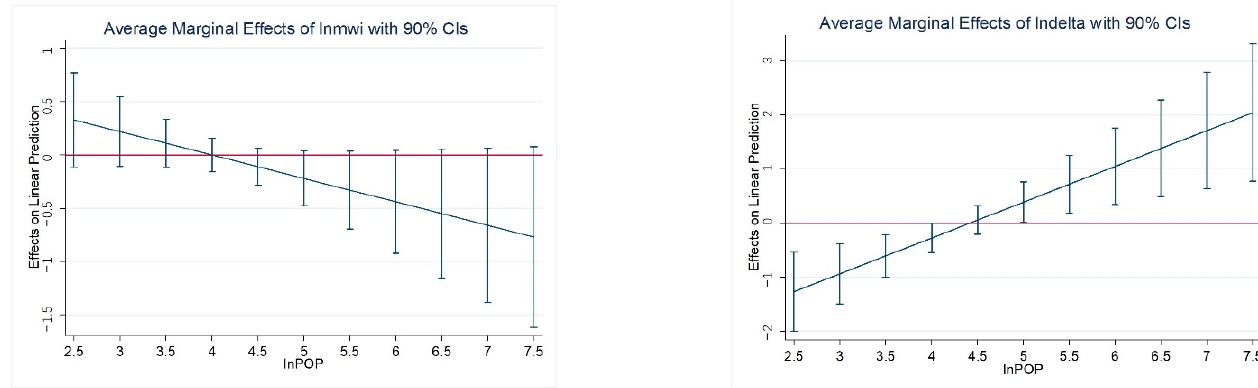
Figure 5. Marginal effects of the spatial structure (based on Model 5 in Table 3). Table 7. Population threshold for the economic effects of the spatial structure. Table 3 Model 5